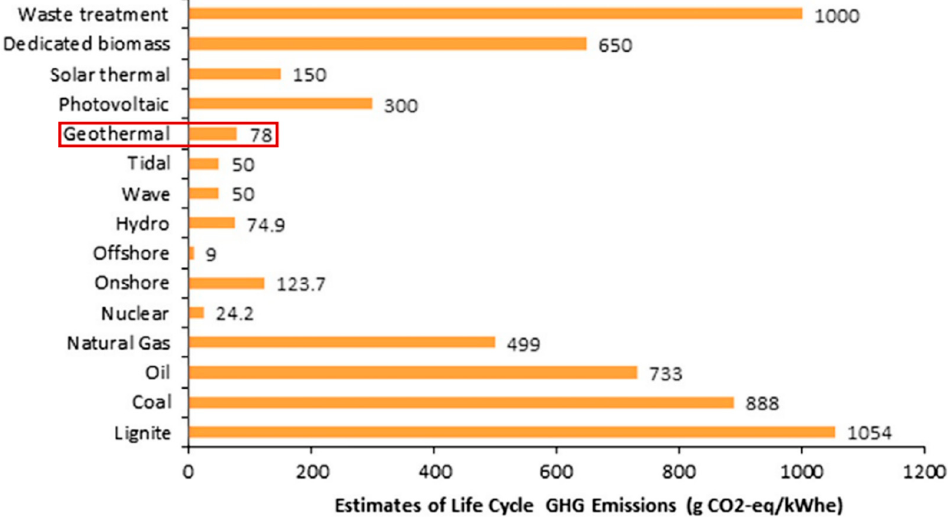
Figure 10. Maximum GHG emission levels from various electricity generation methods [43].